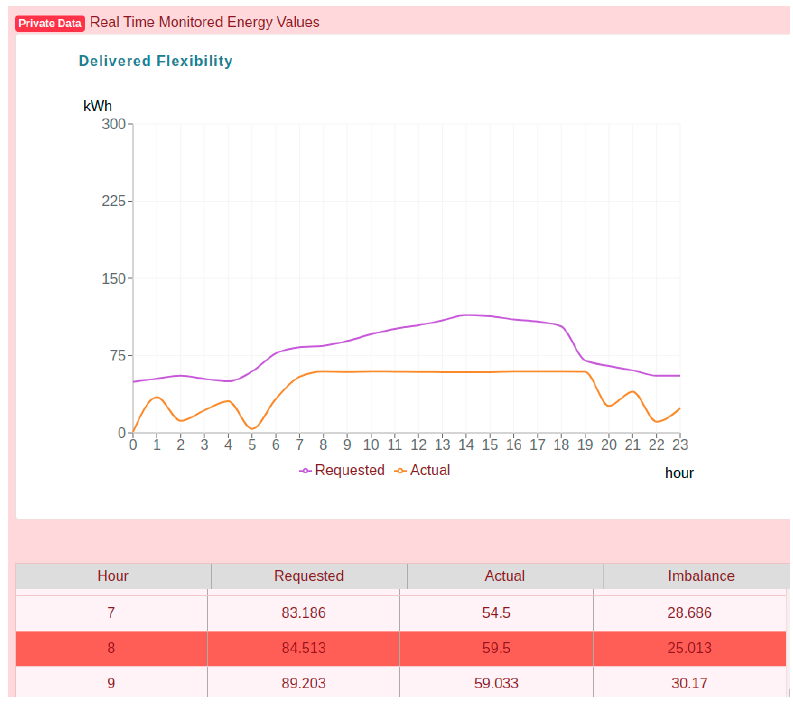
Figure 11. Private energy data available only for the prosumer.